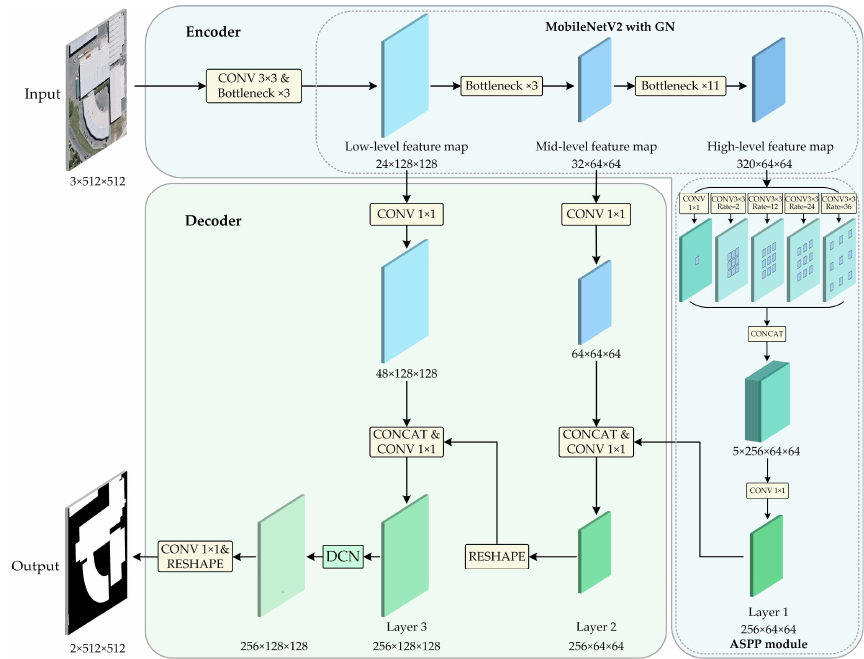
Figure 1. Overall architecture of MSL-Net. The encoder produces multilevel semantic feature maps with different spatial resolutions. The decoder parses them to the segmentation mask. The decoder outputs prediction results with the same size as that of the original input image; these results are expressed as the final binary building segmentation map in the building semantic segmentation task. First, layer 1 is output by the ASPP module